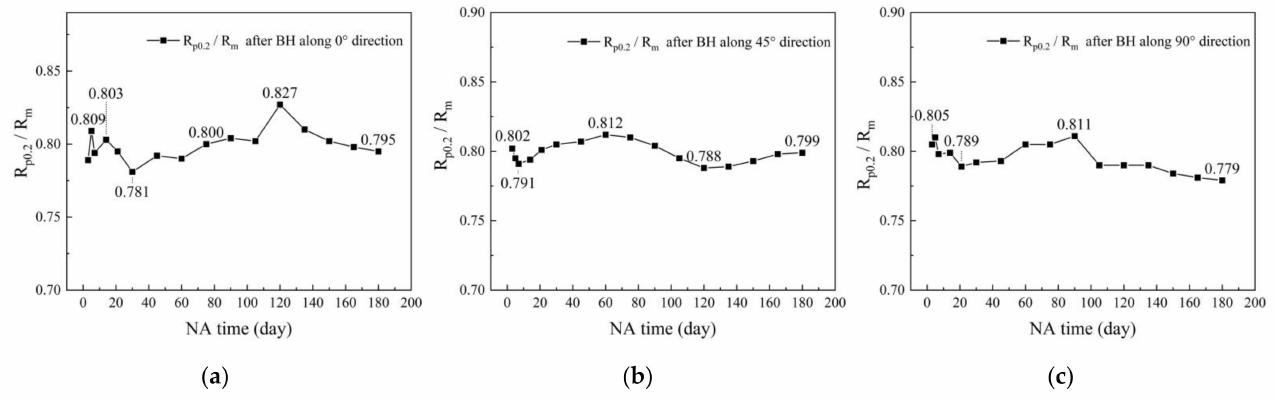
Figure 12. The change curves of R p0.2/ R m after bake hardening (BH) along 0 ◦ ( a ), 45 ◦ ( b ), and 90 ◦ ( c )